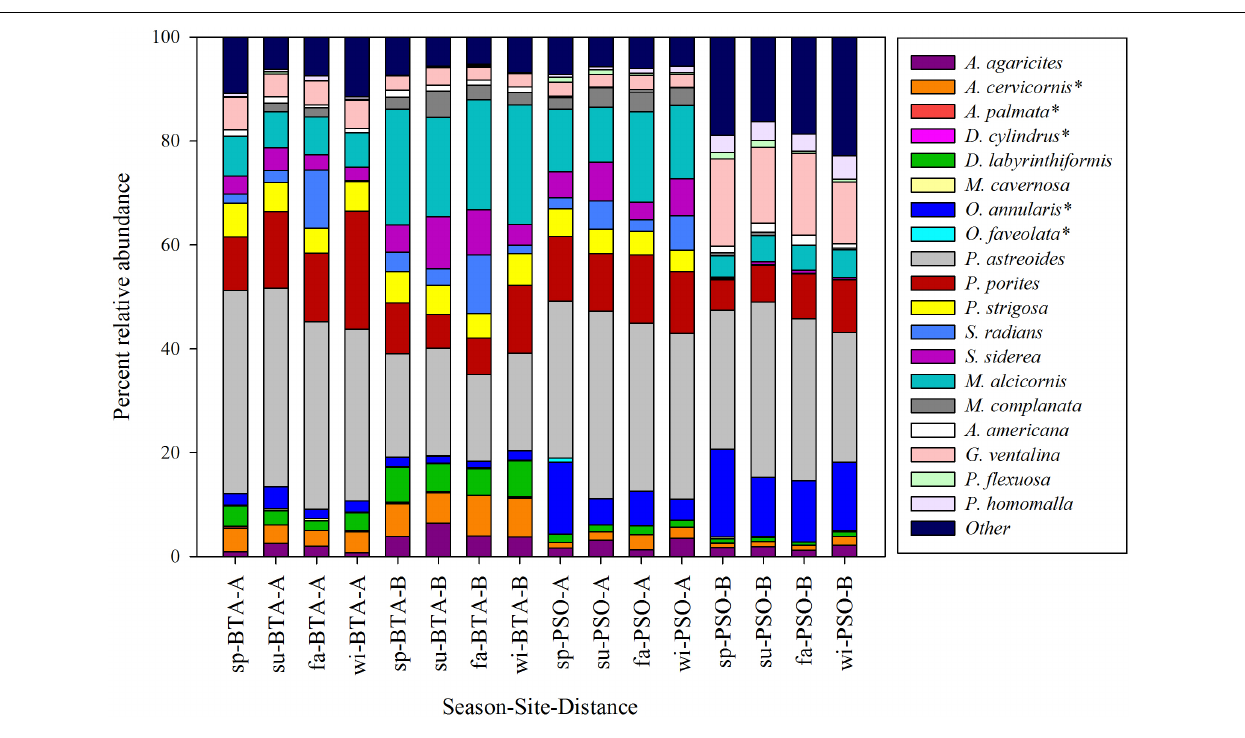
( Table 2 ). No coral recruits of large reef-building coral species were documented at BTA through the study